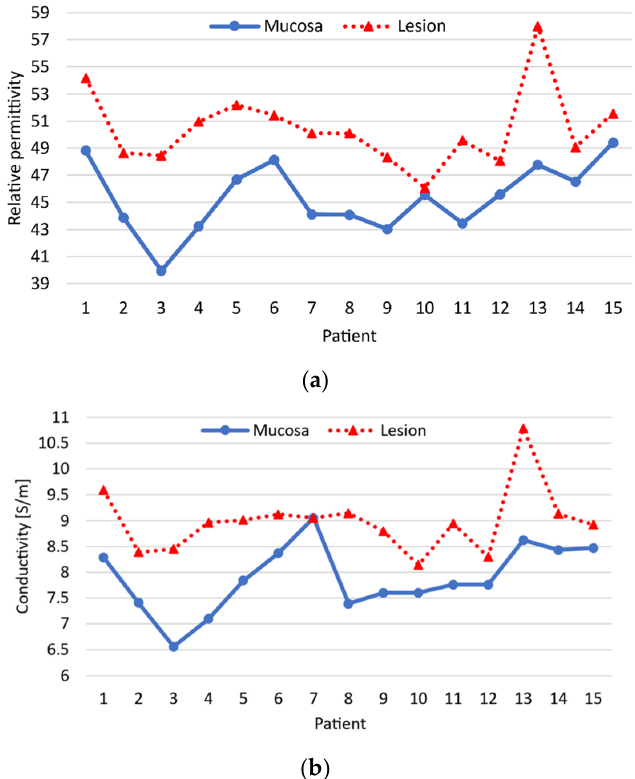
Figure 6. Dielectric properties of the healthy colon mucosa and the neoplasm at 7.6 GHz for each patient was measured with an open-ended coaxial probe. ( a ) Relative permittivity, ( b ) conductivity.